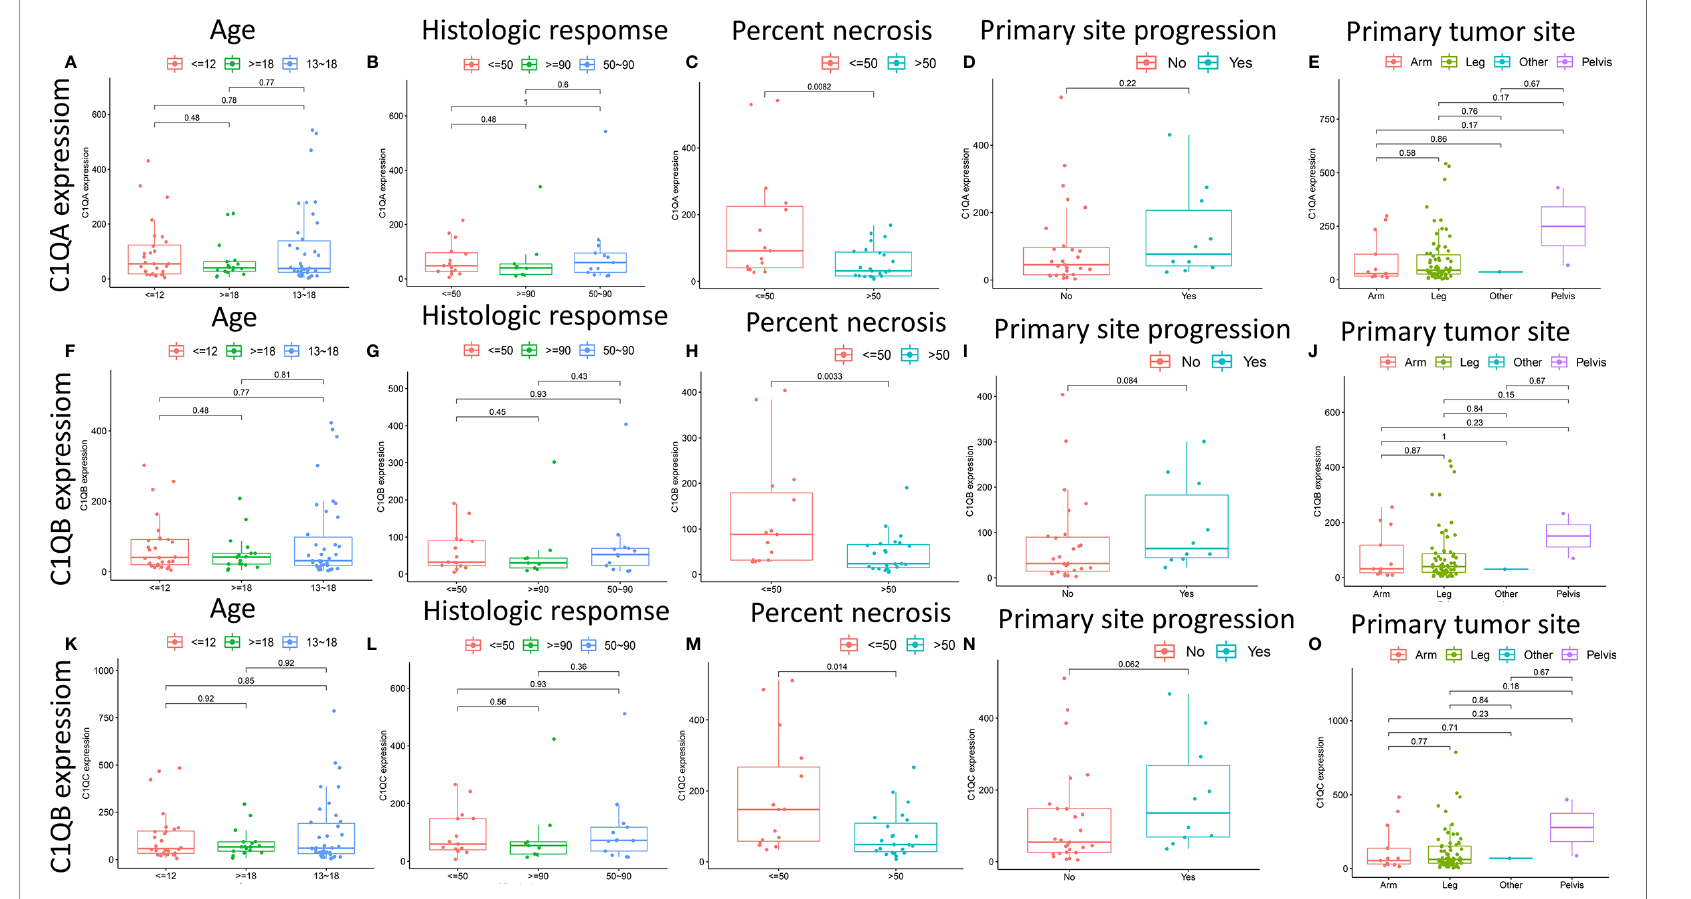
FIGURE 5 | (A – O) Relationships between the levels of C1qA, C1qB, or C1qC expression and clinicopathological features in OS patients. The Wilcoxon rank-sum test or Kruskal-Wallis rank-sum test was applied for statistical